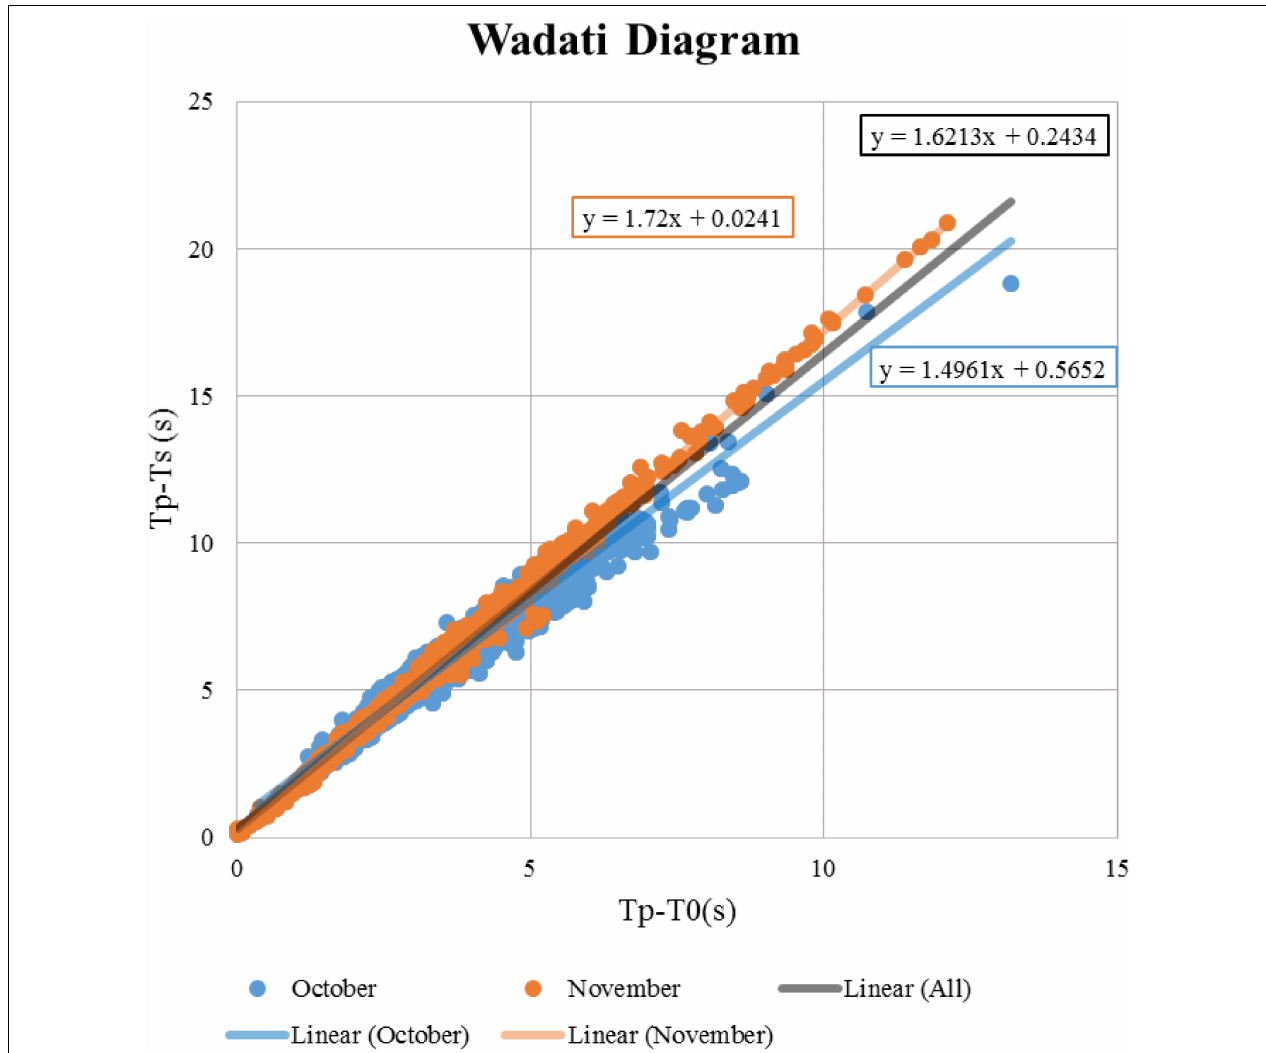
FIGURE 3 | The Wadati diagram of 2,726 VT events recorded during the study period. Based on this diagram, an average Vp/Vs of about 1.62 was found. Two patterns in this Wadati diagram are observed: VT events occurring in October 2017 (blue dots) have smaller gradients compared to the ones in November (orange dots). Consequently, lower- and higher-than-average Vp/Vs were given, respectively. VT events in October and November indicate a Vp/Vs of 1.50 and 1.72,